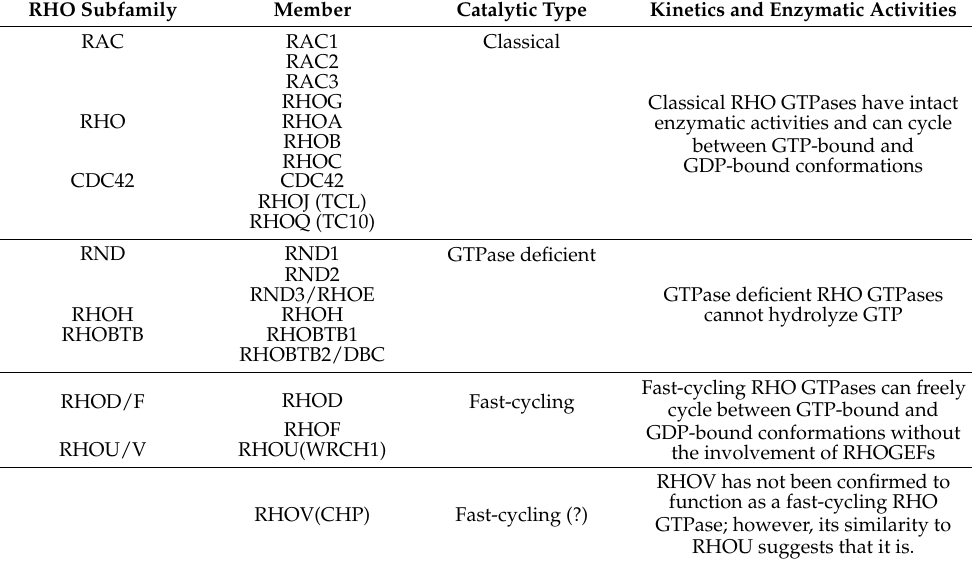
Table 1. Subgroup divisions for the 20 different members of the RHO GTPases in human cells. RHO Subfamily